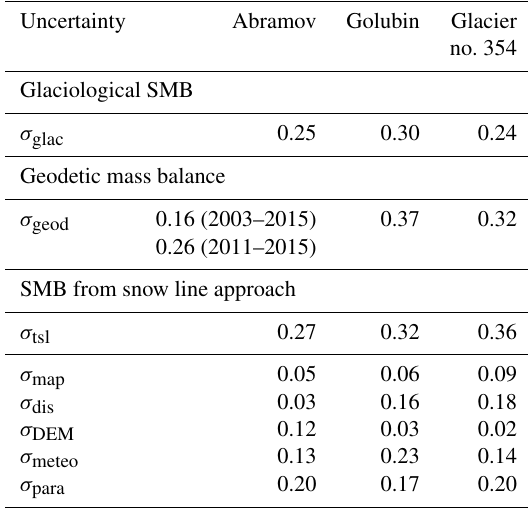
Table 4. Overall average uncertainties related to the three meth- ods used, namely the glaciological σ glac , geodetic σ geod and TSL- constrained modelled mass balances σ tsl for all three investigated glaciers in mw.e.yr − 1 . Additionally, the uncertainty for each com- ponent of the snow line approach is specified. σ map shows the un- certainty of the TSL delineation, σ dis the uncertainty related to im- age frequency and distribution and σ DEM to the DEM. σ meteo in- dicates the uncertainty introduced by the meteorological input data and σ para the one by the model parameter